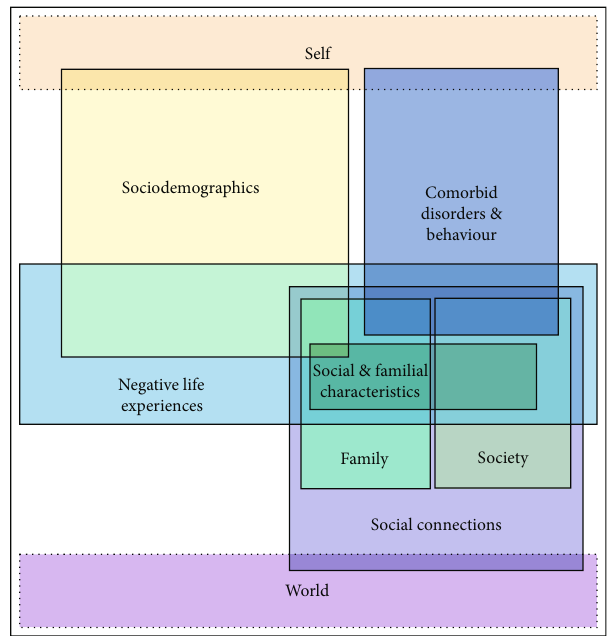
Figure 9: Hierarchical taxonomy of risk factor domains of suicide showing how they are